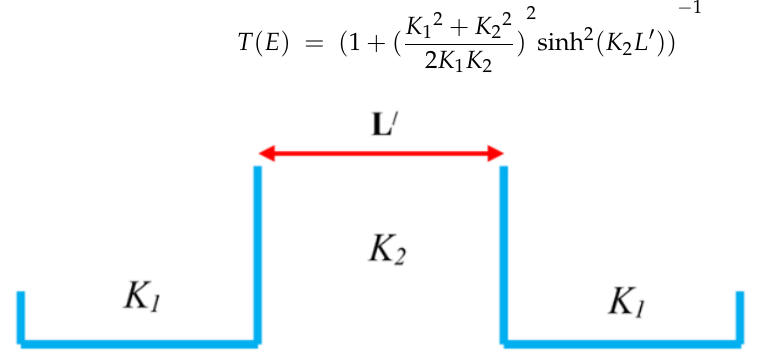
Figure 4. The 1D potential barrier of the proposed twisted graphene Schottky transistor. By replacement of wave vectors in each region, we